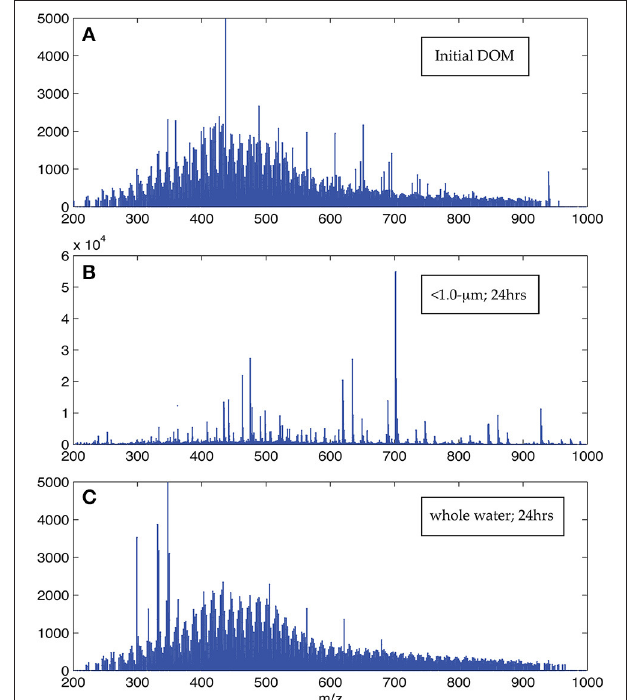
FIGURE 2 | Representative ESI FT-ICR positive ion mode mass spectra. Panel (A) is the initial DOM prior to the start of the incubation, Panel (B) is the < 1.0- µ m spectrum, and Panel (C) is the whole water spectrum after 24h. The visual difference evident here was present in all pairs of spectra collected at the same time point in the experiment, although spectra within each category did not change appreciably with time.